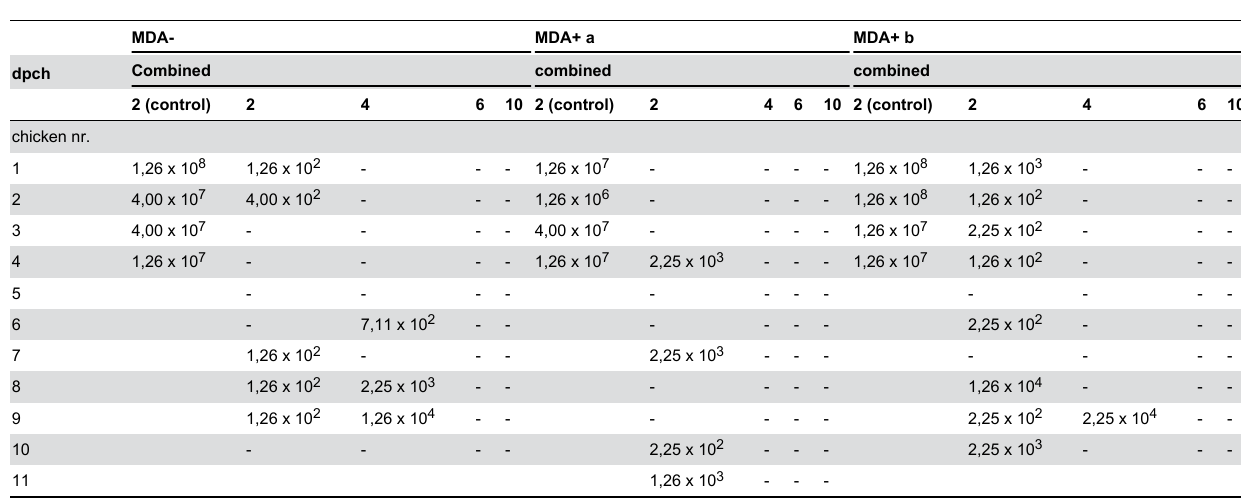
Table 2. Shedding of infectious virus after challenge (TCID